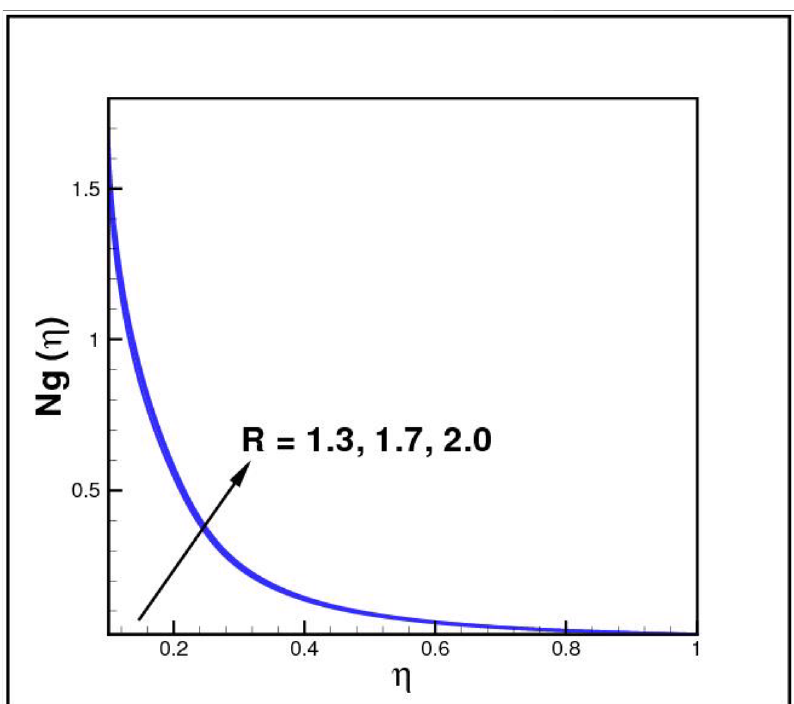
Figure 14. Impact of R on Ng ( η